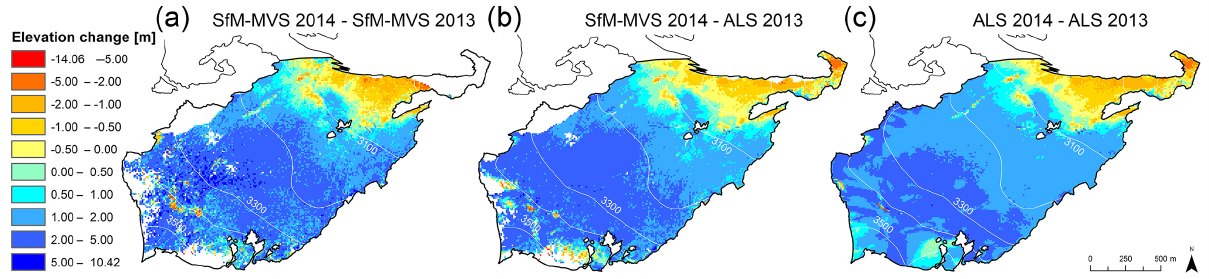
Figure 17. Spatial distribution of elevation changes between (a) SfM–MVS 2014 and SfM–MVS 2013 DEMs, (b) SfM–MVS 2014 and ALS 2013 over the area of the glacier with common coverage, and (c) ALS 2014 and ALS 2013 over the entire glacier.